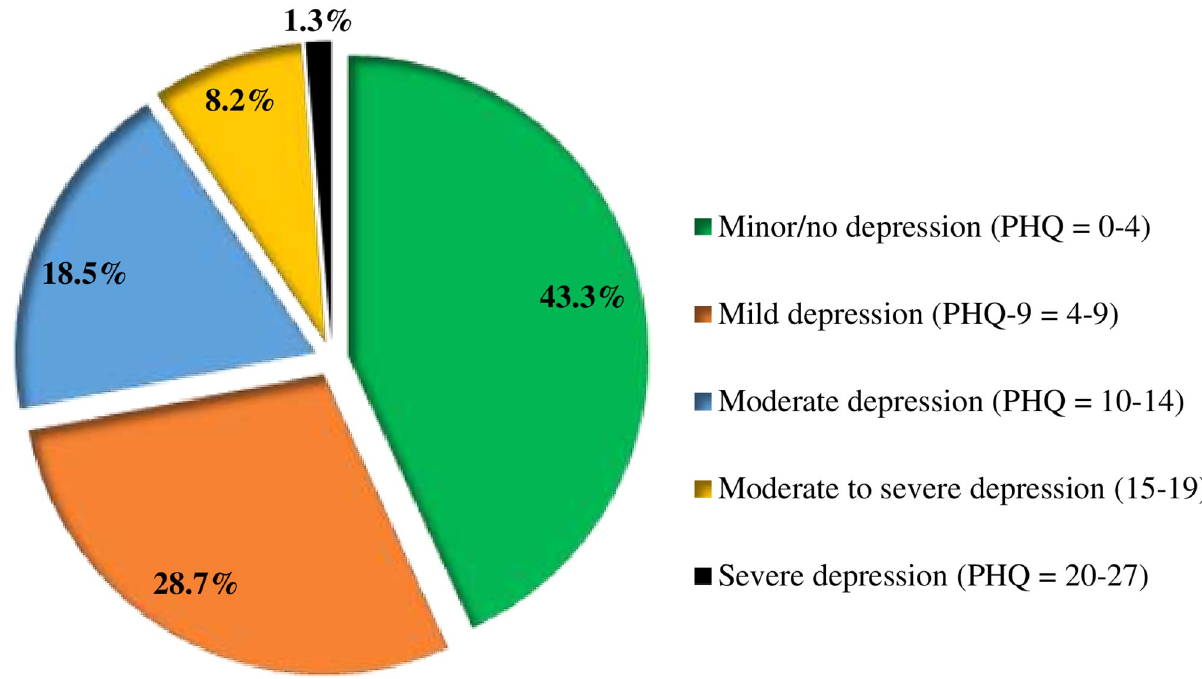
Fig 2. Magnitude and severity of depression among school-going adolescent in Jimma town, Southwest Ethiopia (n = 546).